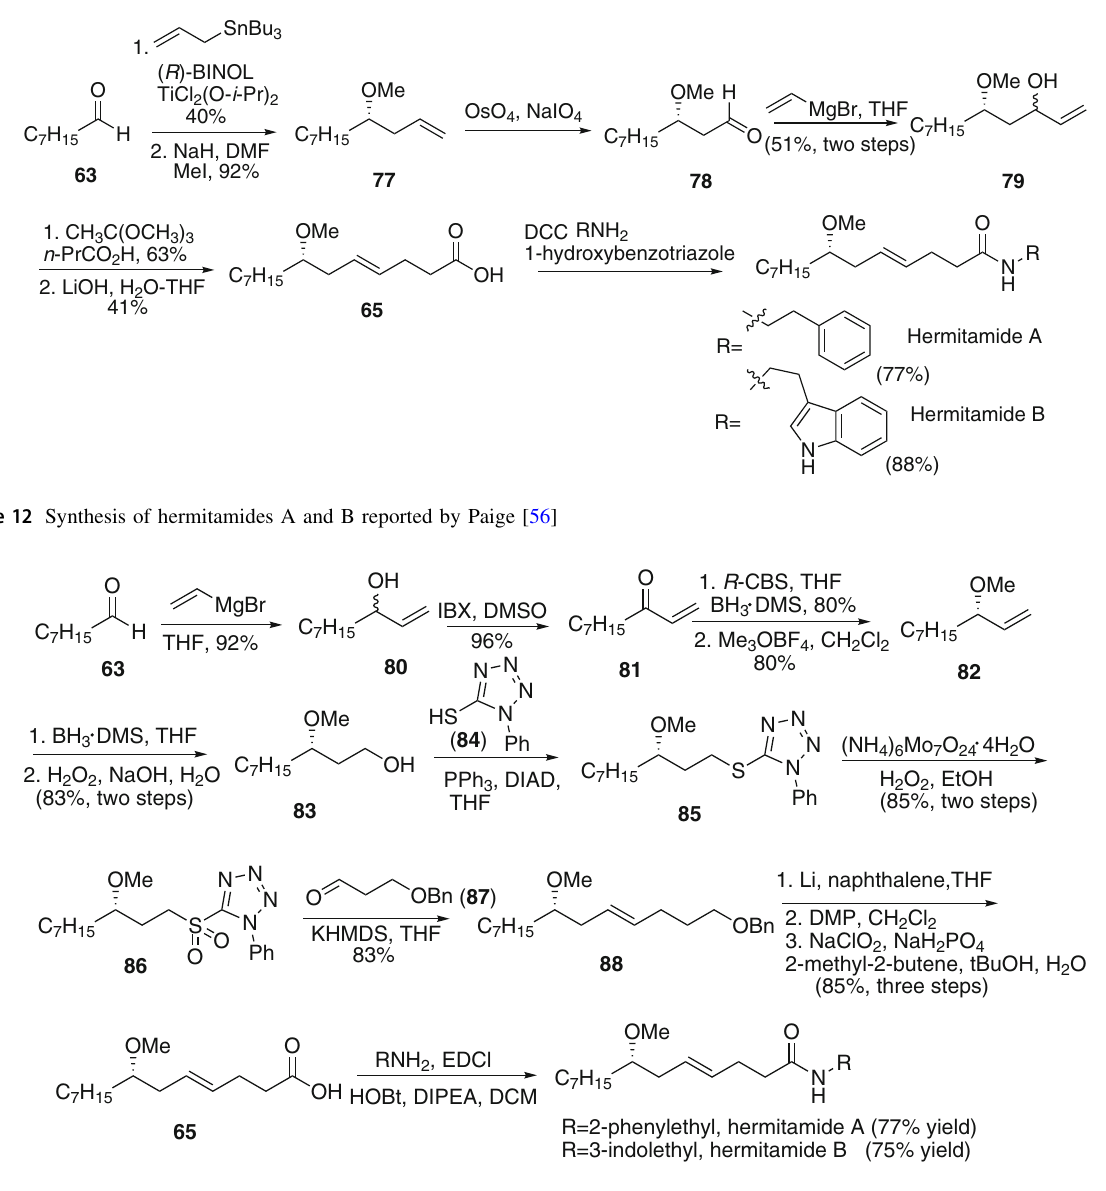
Scheme 13 Synthesis of hermitamides A and B reported by Narender